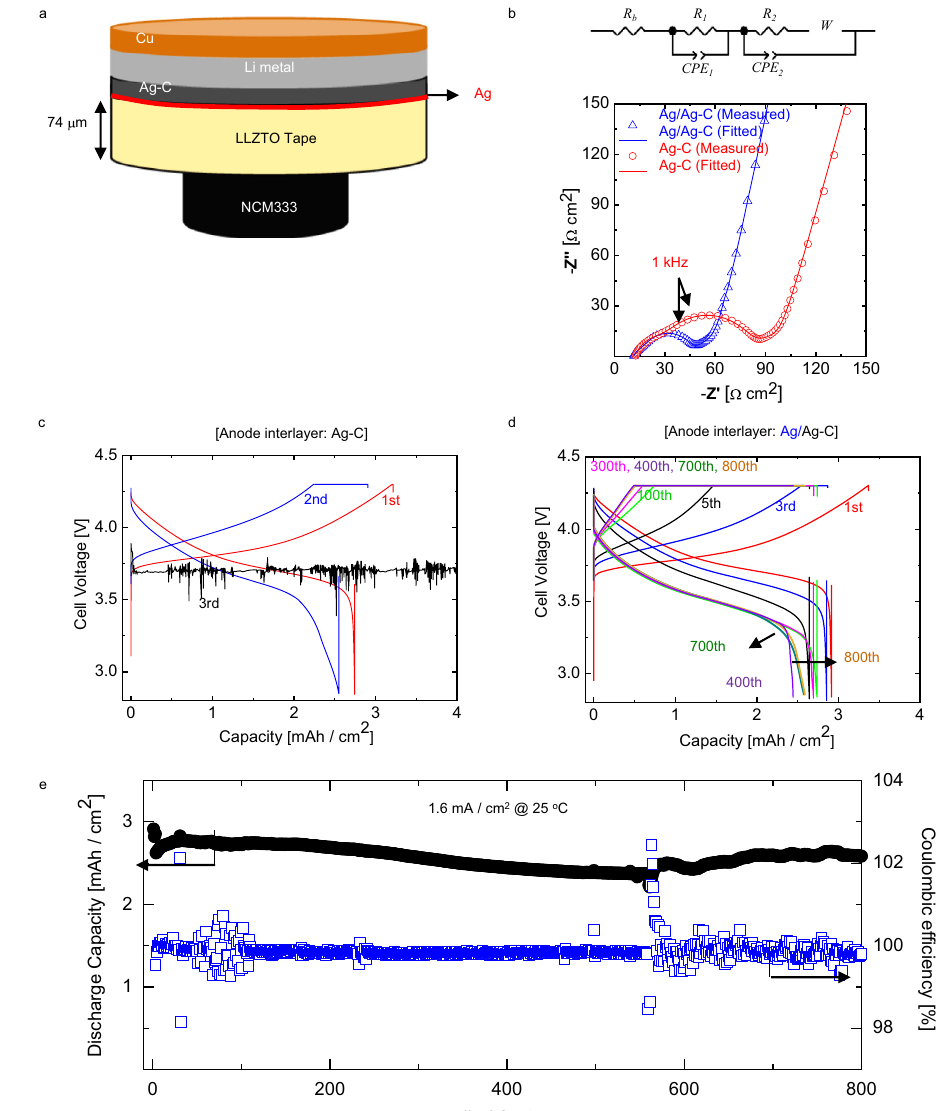
Fig.5|InterfacestabilizationeffectusingAginterlayerinLi|Ag-C/Ag/LLZTO/IL| NCM333single-layerpouchcells.a Schematicpictureoftheassembled cellusing LLZTO tape. b Nyquist plots of AC-impedance spectra obtained from the Li|Ag-C/ Ag/LLZTO/IL|NCM333 single-layer pouch cells (inset: equivalent circuit).